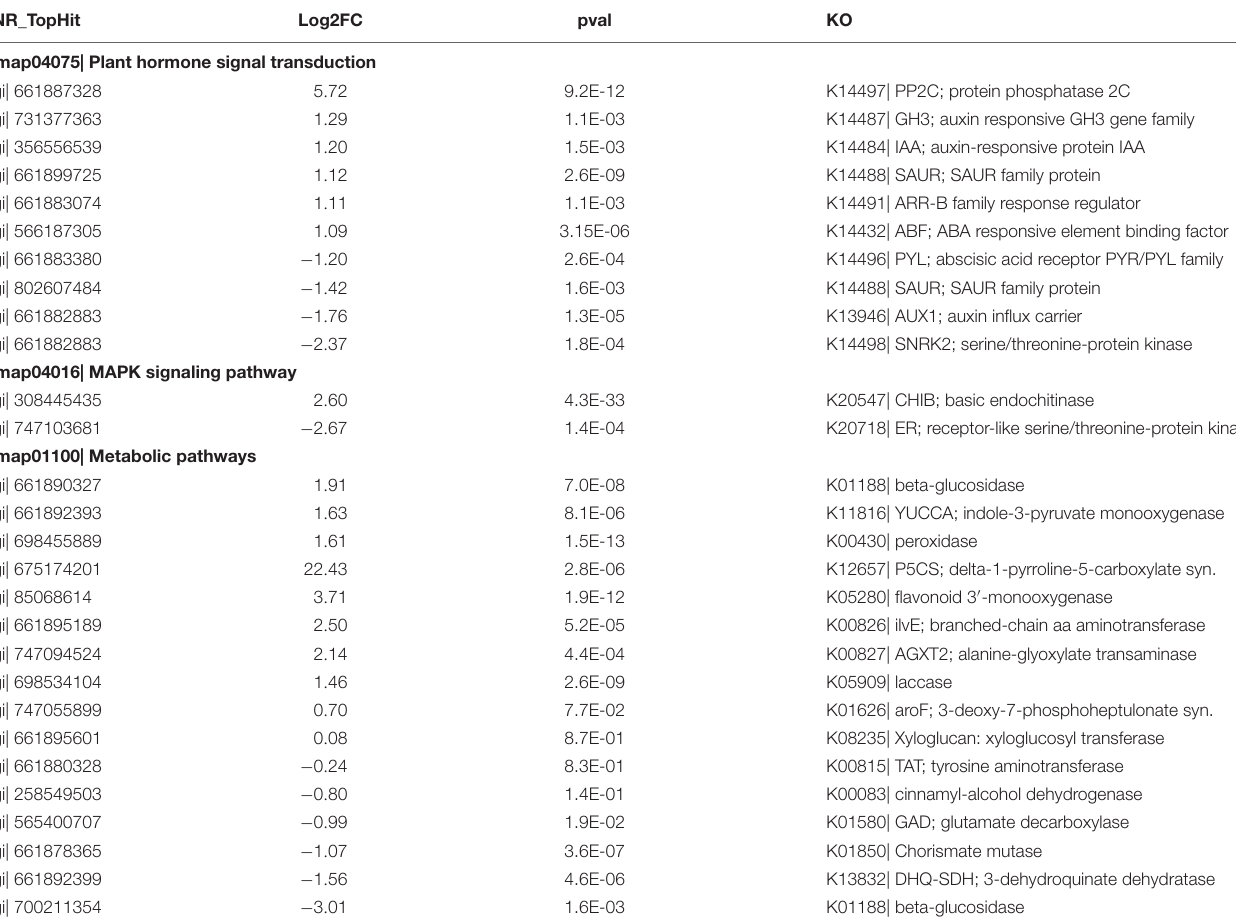
TABLE 2 | Differentially expressed genes (DEGs) selected in the roots of S. argel plants under salt stress conditions. NR_TopHit Log2FC pval KO map04075| Plant hormone signal